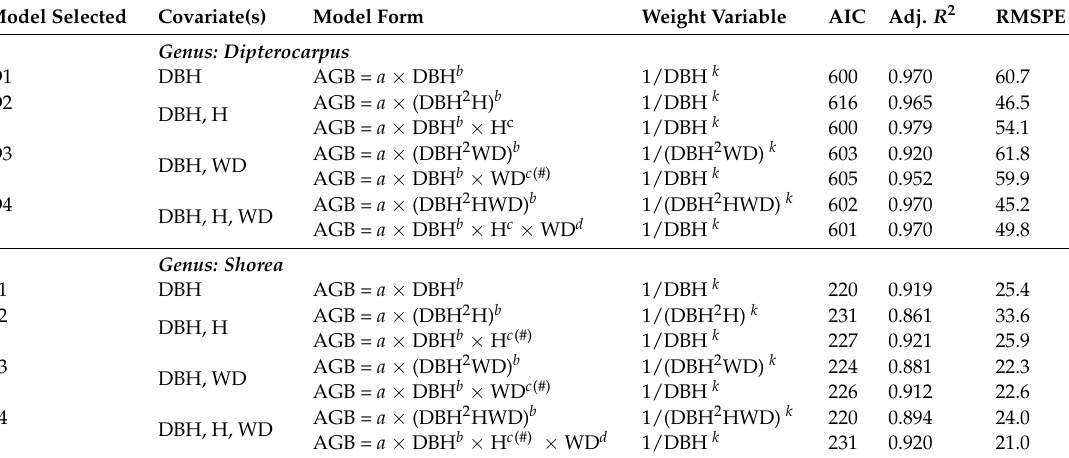
Table 5. Comparison of different AGB models with different input variables for Dipterocarpus (67 trees) and for Shorea (26 trees).